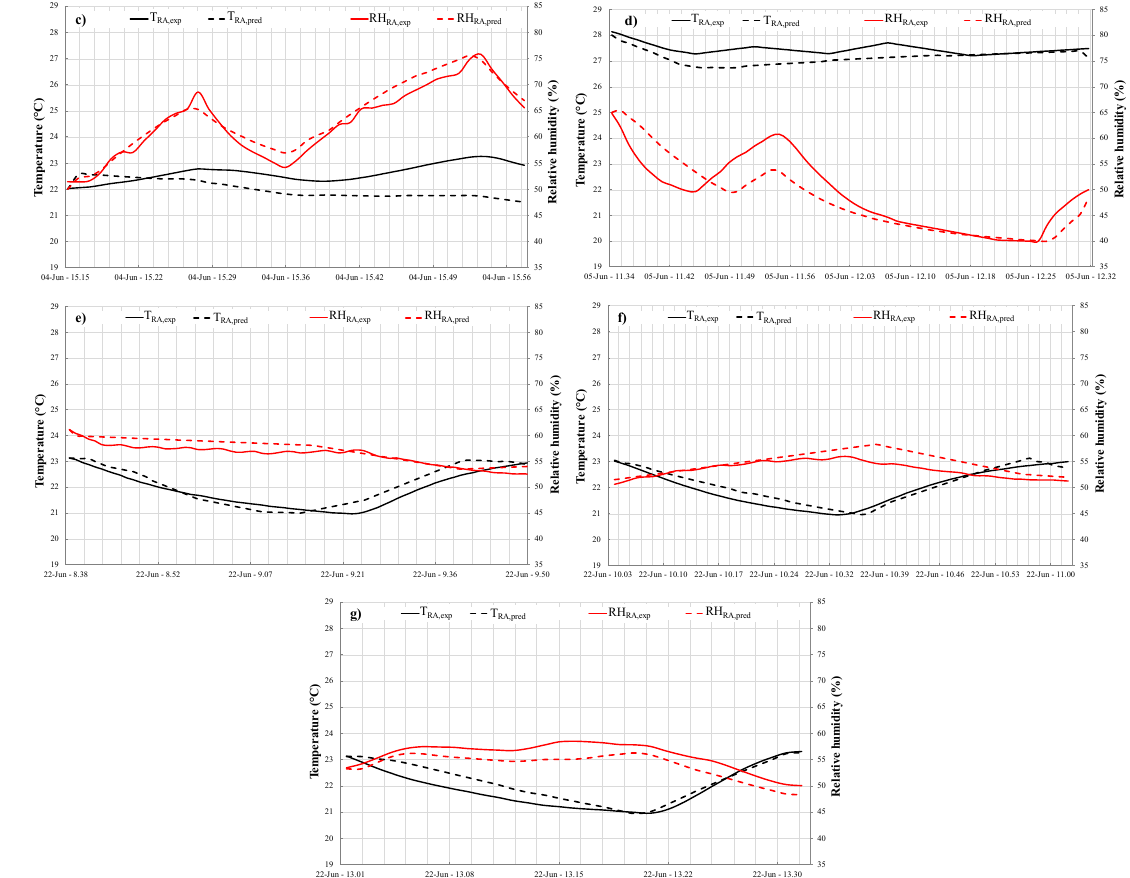
Figure 6. Comparison of the experimental results with the predicted data: test 1 ( a ), test 2 ( b ), test 3 ( c ), test 4 ( d ), test 5 ( e ), test 6 ( f ) and test 7 ( g ).